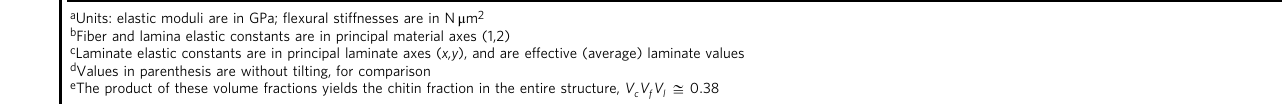
Fig. 8a – c, which show the elastic constants as functions of the transformation angle ψ (around z -axis) of the coordinate system x ′ y ′ with respect to xy . It is seen that at intermediate values of ψ , the anisotropy may even grow as a result of the larger asymmetry of the BLU with respect to the x ′ y' system; for example, minimum at ψ ffi 50 (cid:4) (Fig. 8a), and (cid:1) η (Fig. 8c). Note that in these plots, at ψ = 0 the subscripts x ’ and y ’ can be replaced by x and y , respectively ( E at ψ = 90° they can be replaced by y and x , respectively ( E etc.).